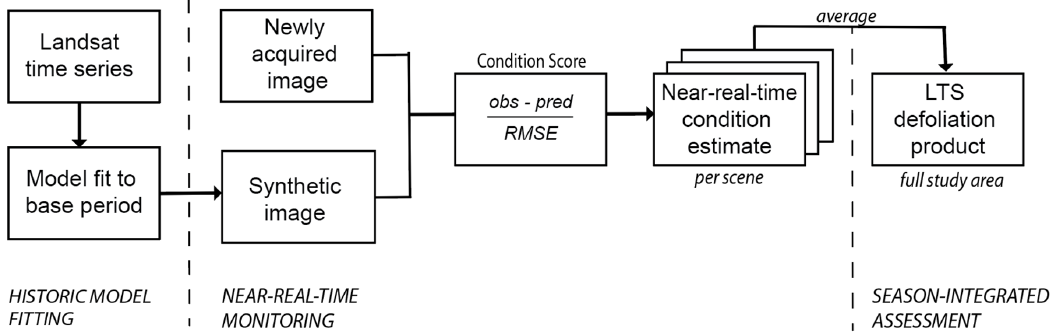
Figure 1. General workflow of methods used to assess defoliation damage from the 2016 gypsy moth ( Lymantria dispar ) outbreak in Southern New England. Landsat time series are used for historic model fitting. Each newly acquired image is compared with a synthetic image for the same date during near-real-time monitoring, resulting in per scene condition estimates for each acquisition date. At the end of the monitoring period, all near-real-time estimates are averaged to generate a season-integrated defoliation assessment for the full study area.